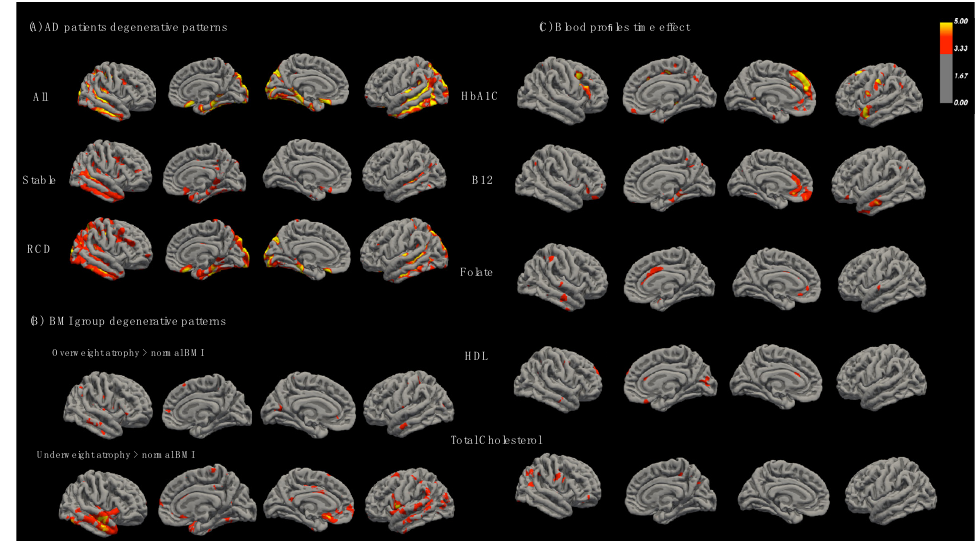
Figure 3. The cortical thickness changes in brain magnetic resonance imaging. ( A ) Changes in AD patients, stable and rapid cognitive decline groups. ( B ) BMI effects showing overweight or under- weight BMI in contrast with normal BMI. ( C ) Significant regions related to blood chemistry profiles. BMI: body mass index. Color bar indicate log ( p -value), parametric Gaussian-based simulations to compute the false-positive rate 0.05 and a vertex-wise threshold of 3.0.